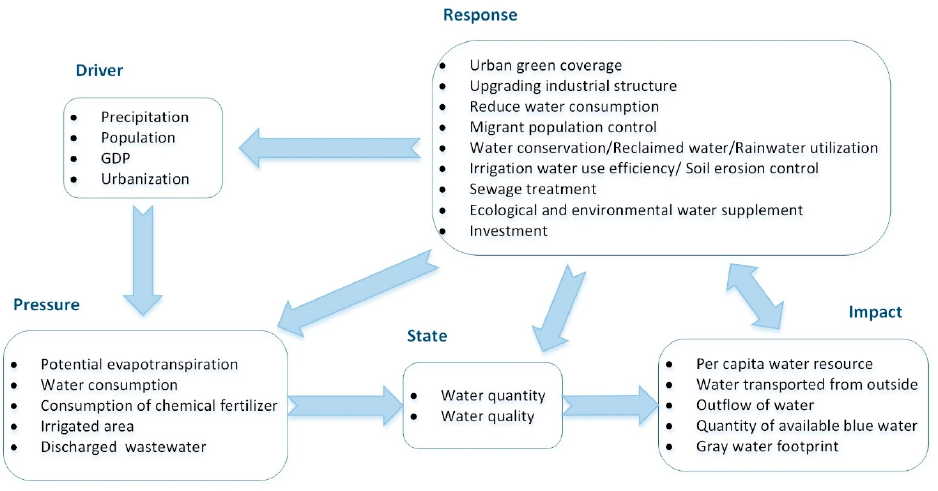
Figure 2. The driver-pressure-state-impact-response (DPSIR) framework for Beijing.